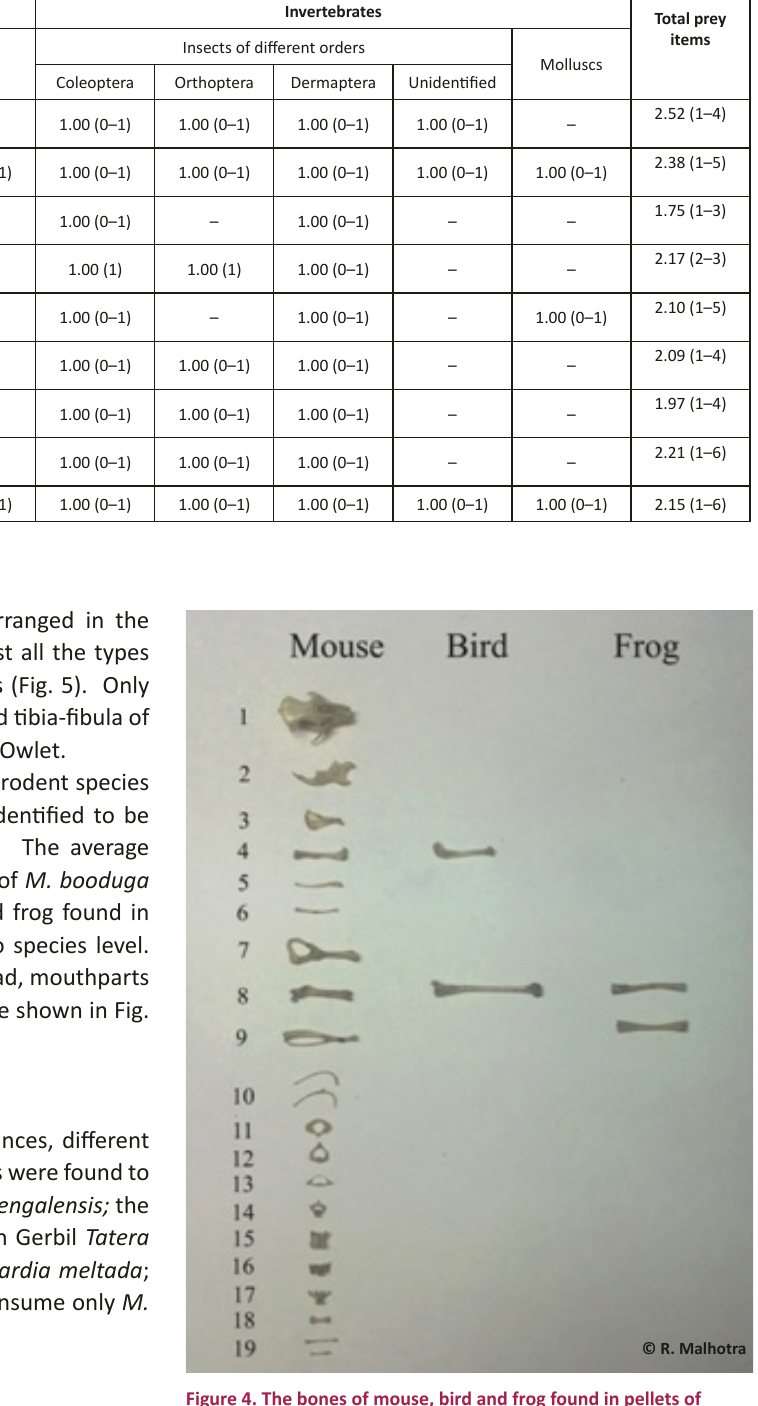
Figure 4. The bones of mouse, bird and frog found in pellets of Spotted Owlet 1-Skull, 2-Lower jaw, 3-Shoulder blade, 4-Humerus, 5-Ulna, 6-Radius, 7-Hip bone, 8-Femur, 9-Tibia-Fibula, 10-Ribs, 11-Atlas, 12-Axis, 13-Cervical vertebra, 14-Thoracic vertebra, 15-Lumbar vertebra, 16-Sacral vertebra, 17, 18-Caudal vertebra, 19-Hand/Foot bones.